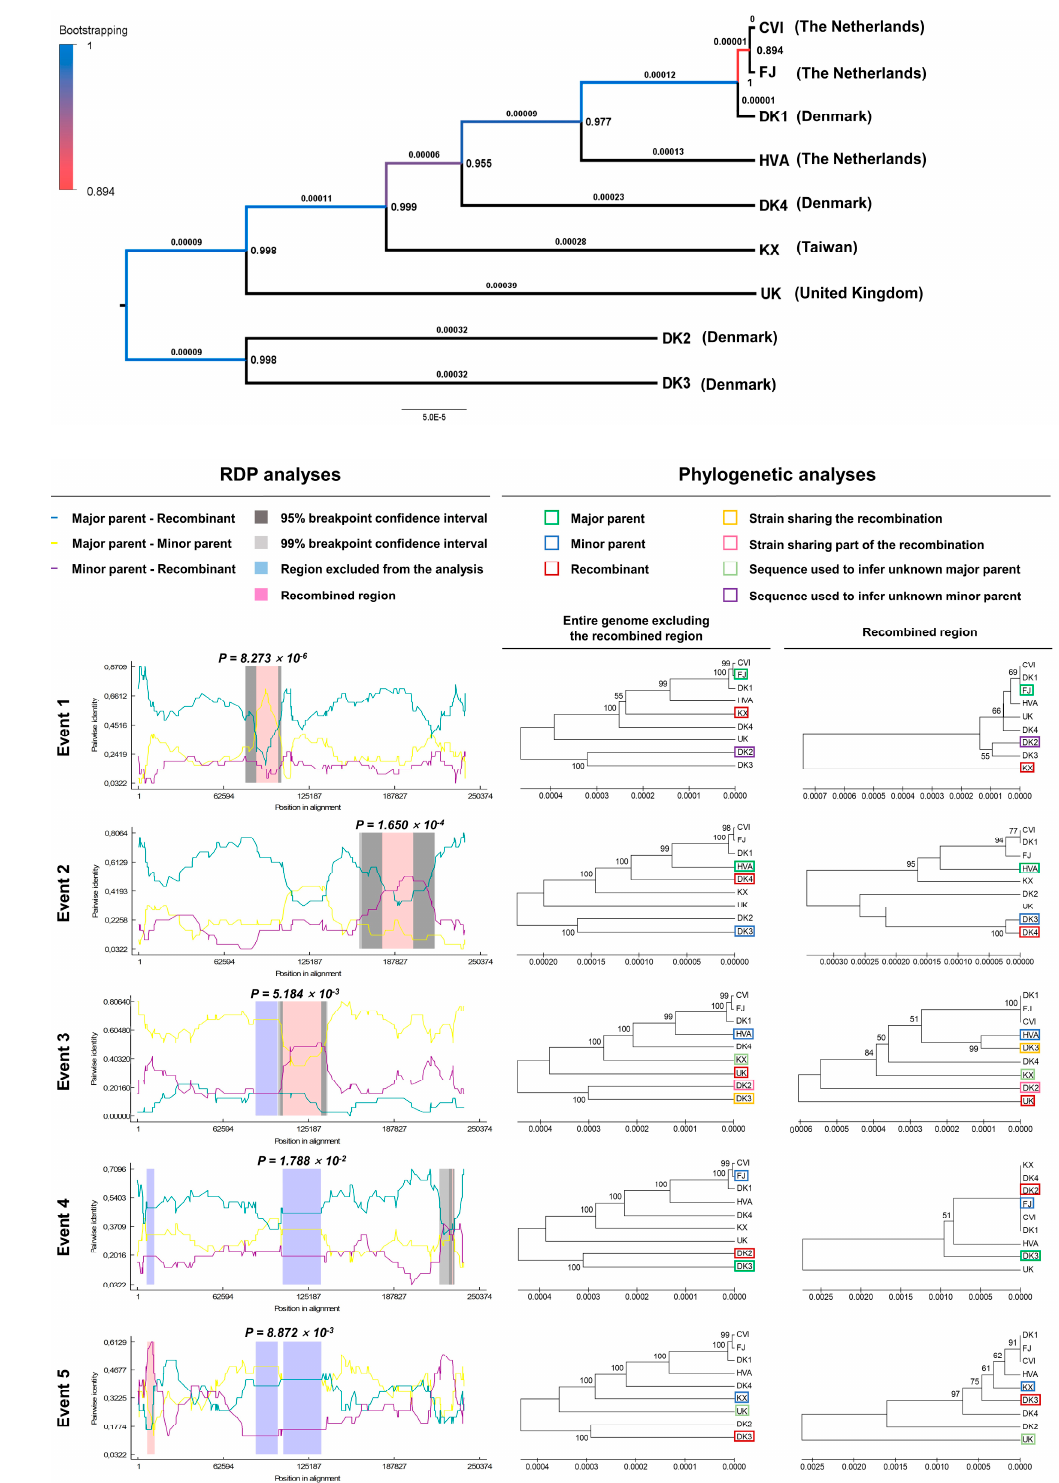
Figure 1. Analysis of AngHV-1 genome sequences. ( a ) Phylogenetic analysis (UPGMA). Bootstrap values (1000 replicates) are indicated at the right of each node. These values are also illustrated by the colors of the branches leading to each node. Numbers above each branch represent substitutions per nucleotide observed along the branch. The geographical origin of each strain is indicated in brackets. ( b ) Recombination analysis. Five potential recombination events were identified using nine sequenced isolates as input. For each event, the left column illustrates the results of RDP analyses, including locations of recombination events and p -values. The middle and the right columns show phylogenetic analyses based on the genome excluding the region of recombination and the same tree based on the recombination region only, respectively. Numbers